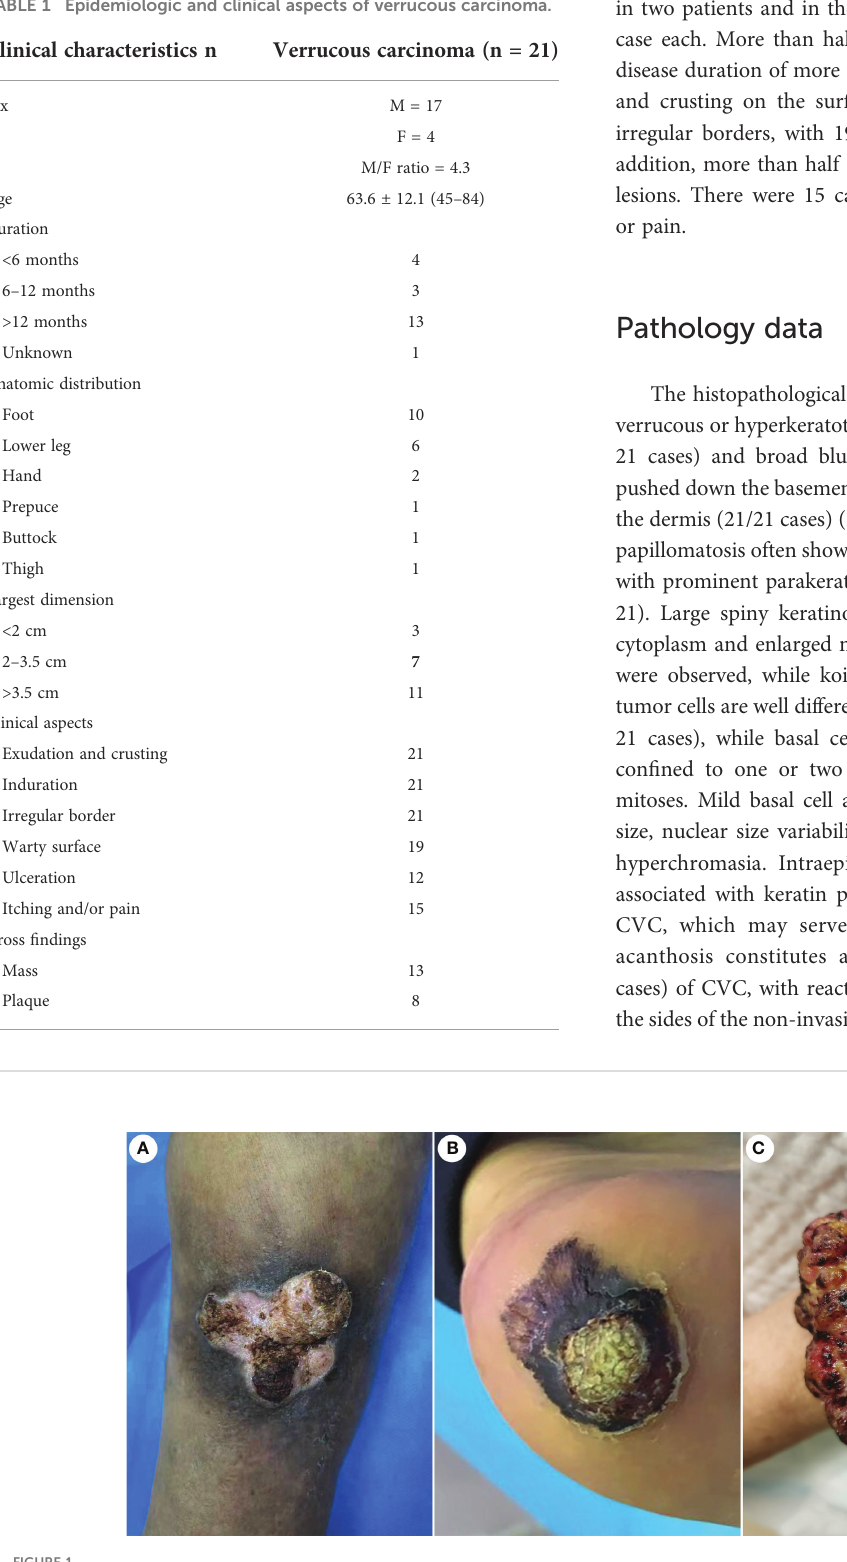
FIGURE 1 Gross features of CVC. (A) A warty plaque with an irregular border on the right lower leg. (B) A verrucous mass in the left foot. (C) A large verrucous mass in the right hand. CVC, cutaneous verrucous